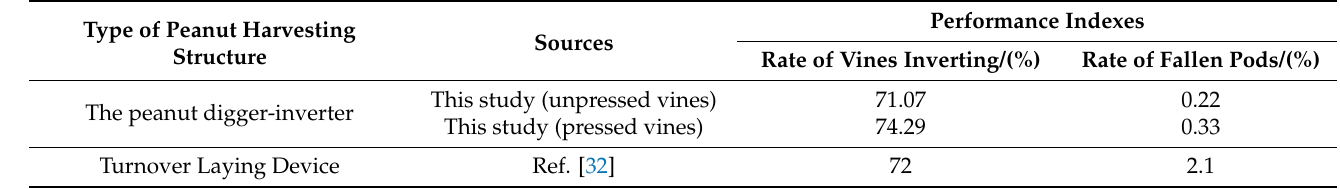
Table 11. Comparison of test results of performance